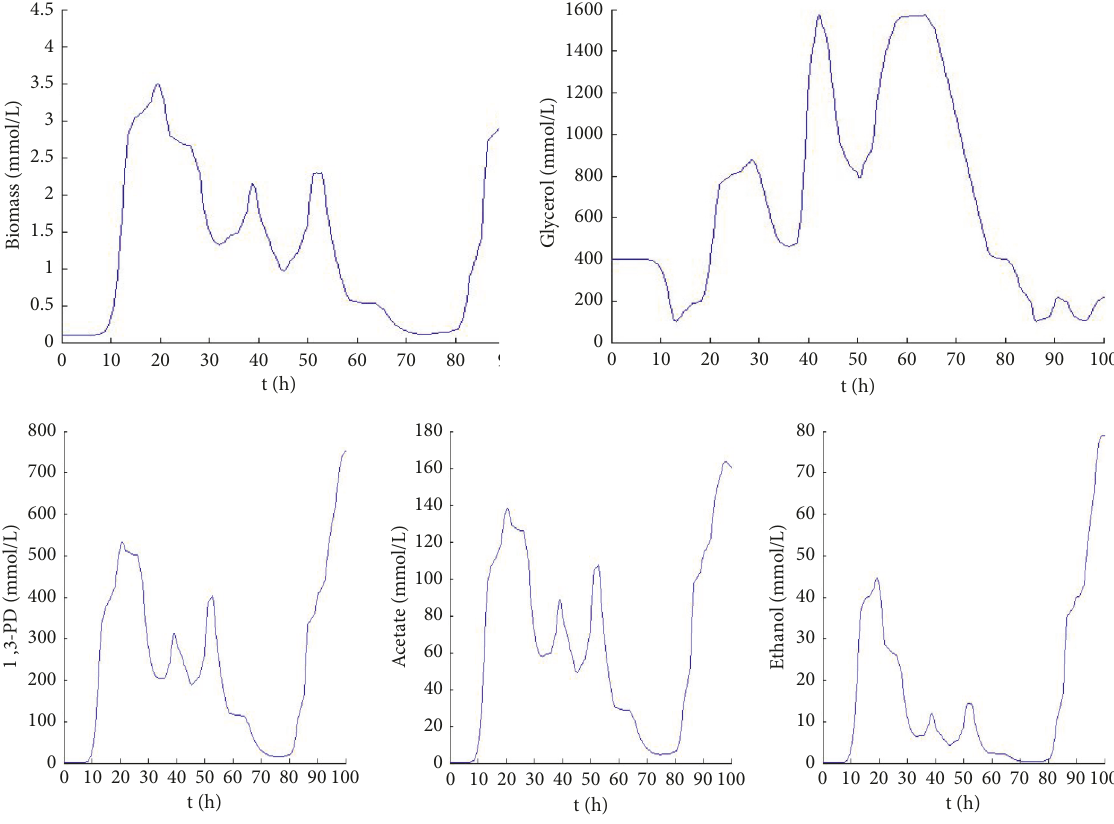
Figure 8: The concentration changes of biomass, glycerol, 1,3-PD, acetate, and